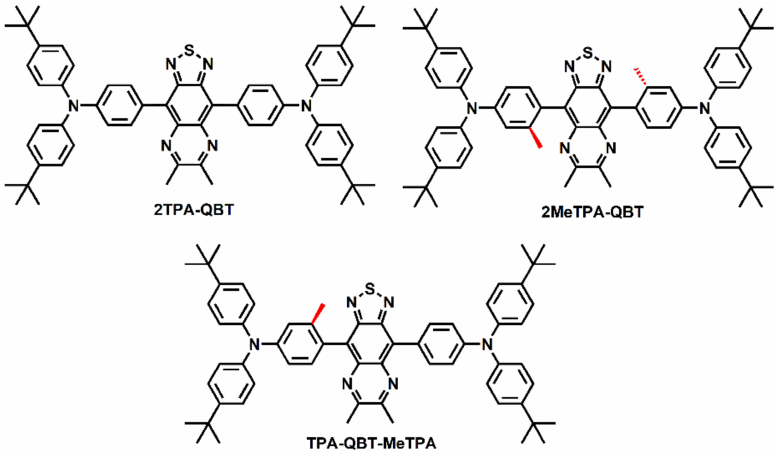
Figure 1. Chemical structures of